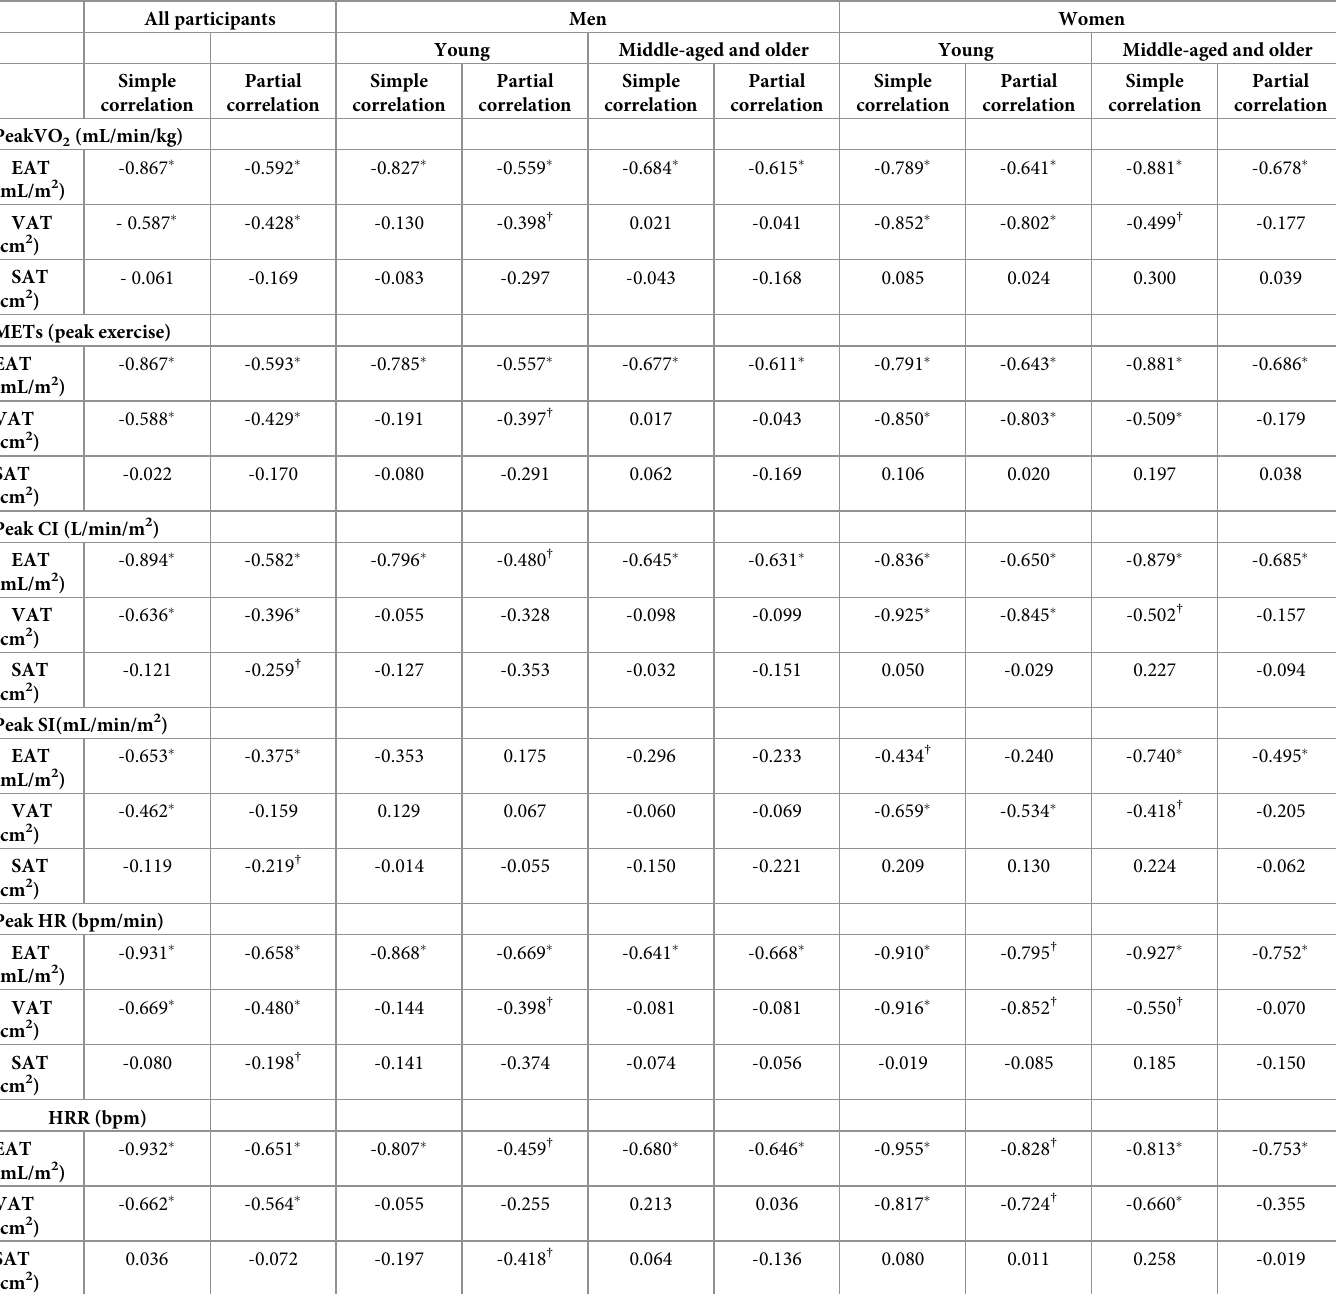
Table 3. Correlation between regional adipose tissue and